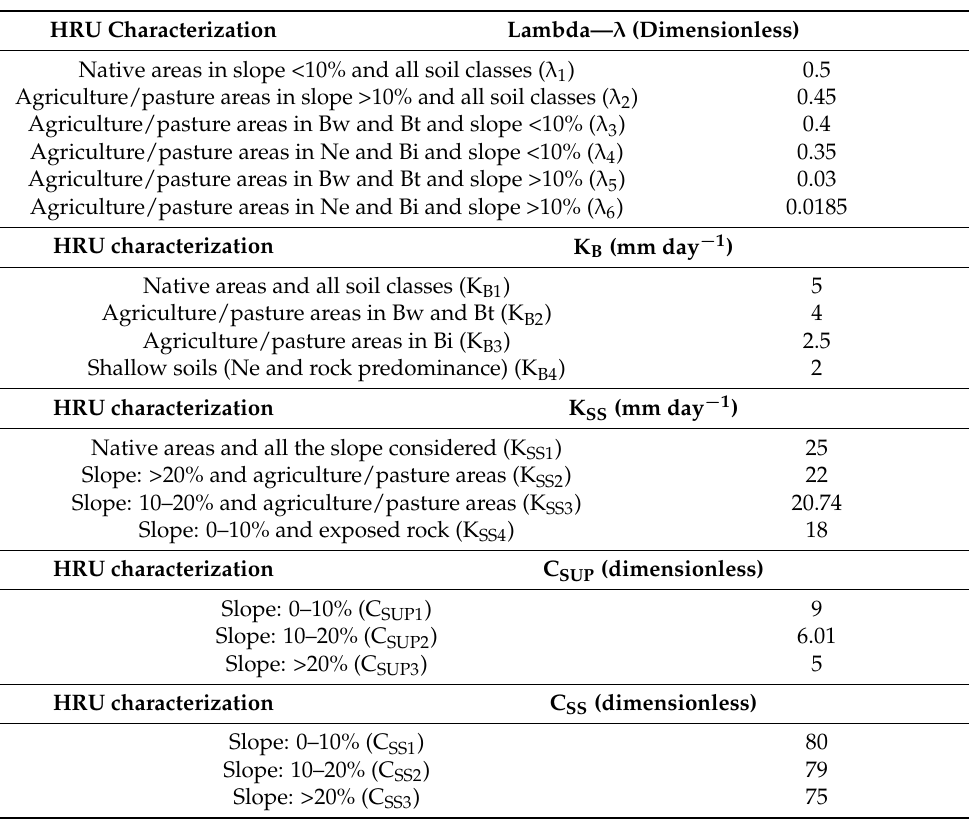
Table 1. Hydrological response units (HRUs) and respective LASH calibrated parameters for the Grande River Basin (GRB)-Furnas